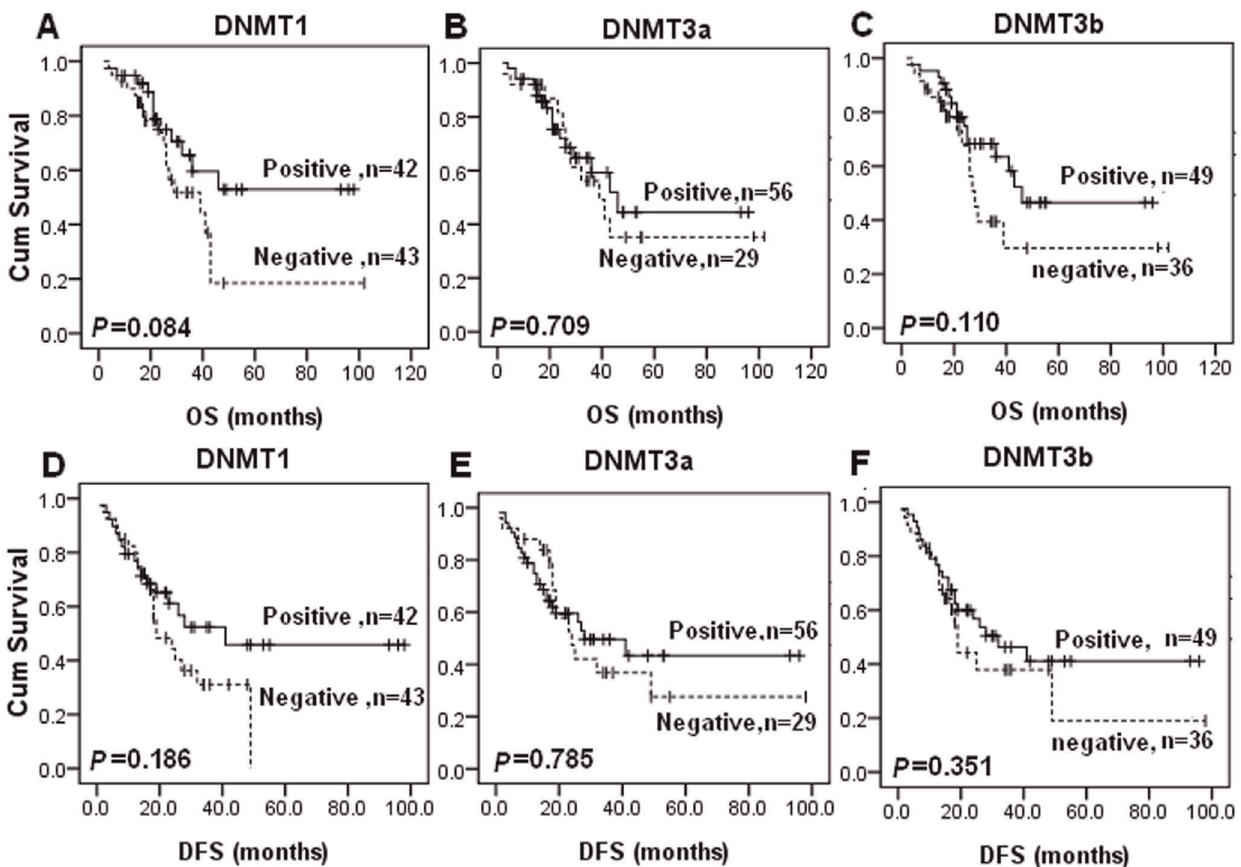
Figure 3. Kaplan-Meier estimates of patients with ovarian cancer stratified by DNMTs protein expression. Survival curves show that although there was no statistical significance, patients with DNMT1 expression had a trend of improved overall survival (A) and disease-free survival (D) than those with negative expression, and so did DNMT3b (C and F). But there is no significant difference between DNMT3a expression and overall survival or disease-free survival (B and E). P -value obtained from the log-rank test.